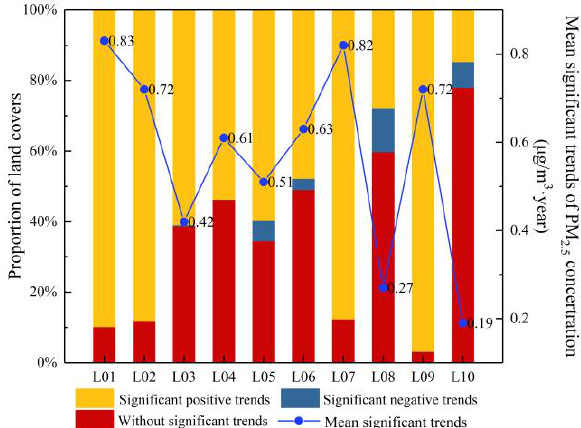
Figure 6. Significant trends of PM 2.5 in different LC types during